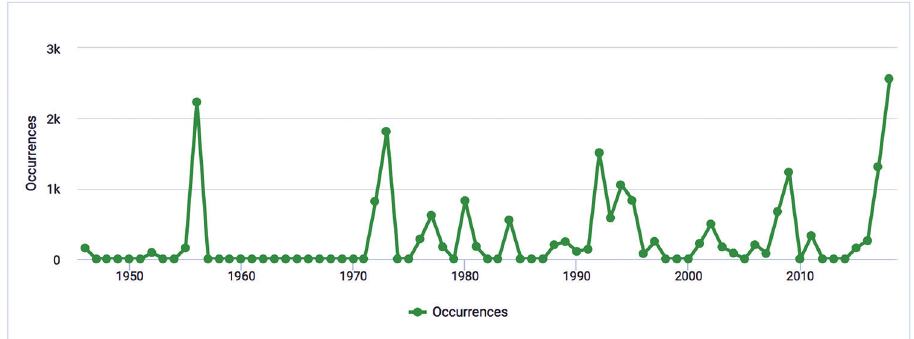
Figure 2. Temporal coverage of the “Segetal flora of Italy” dataset (occurrences per year).